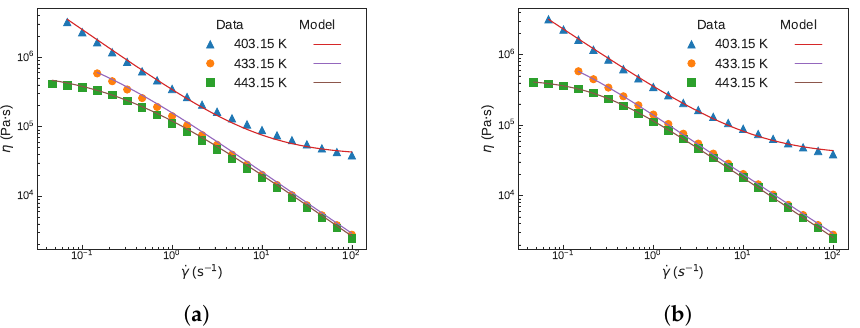
Figure 3. Fitted Carreau–Yasuda model at different temperatures with: ( a ) the traditional approach; and ( b ) Scenario